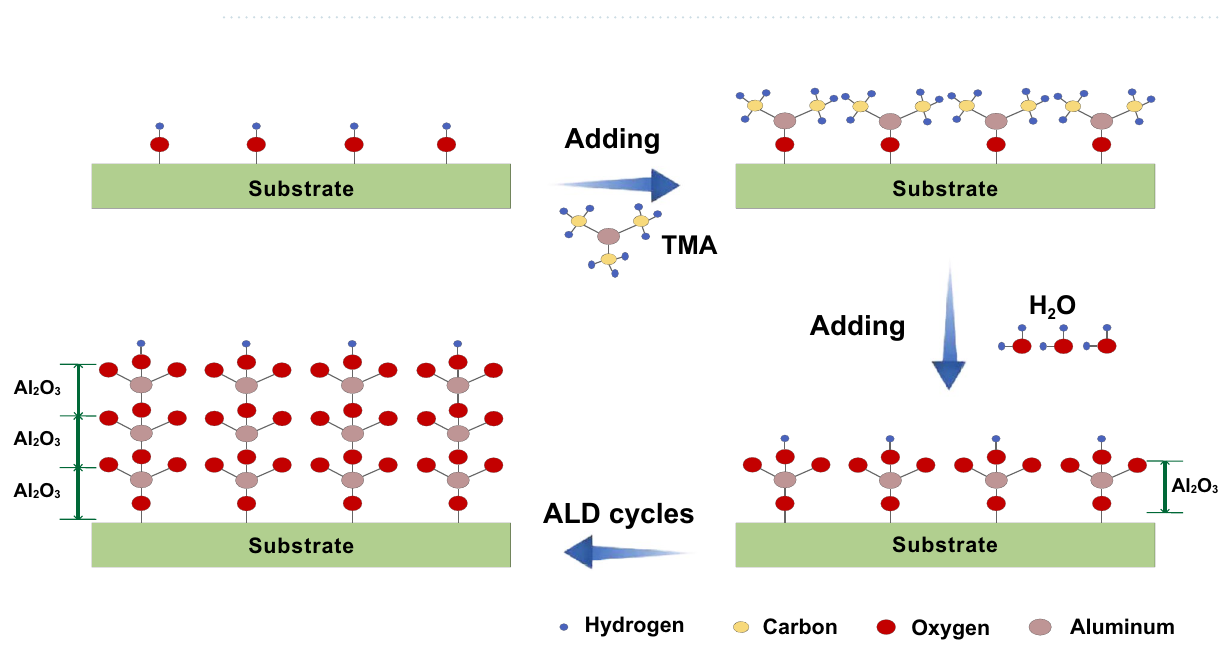
Figure 7. Schematic diagram of ALD process for fabricating Al 2 O 3 film 38